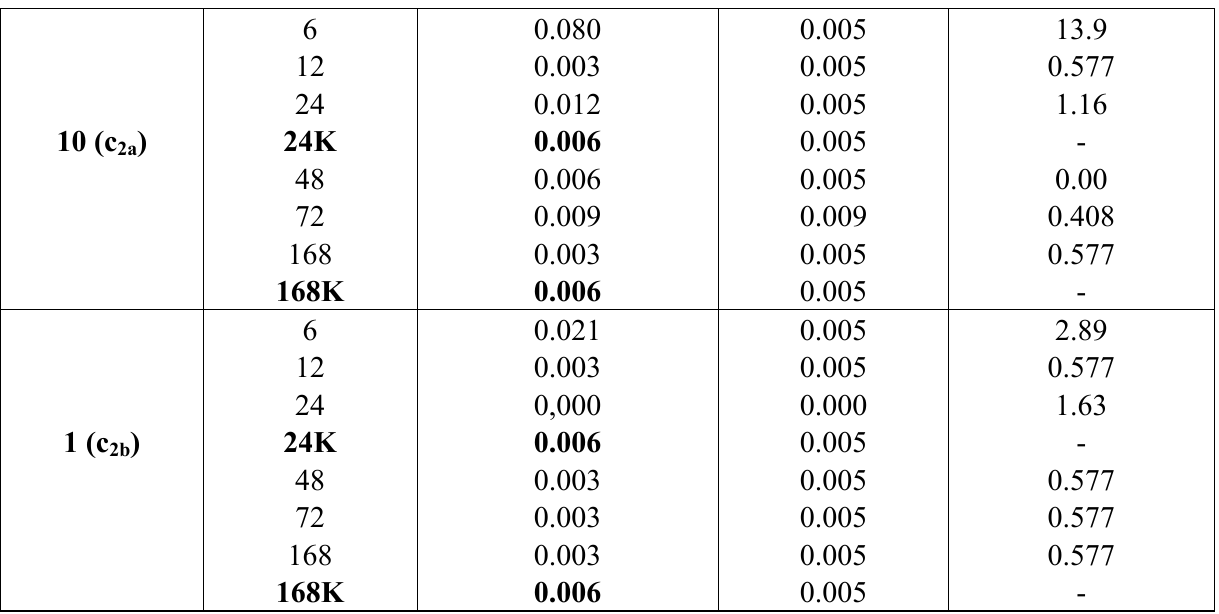
c2=100 mg/100 mL c2a=10 mg/100 mL c2b=1 mg/100